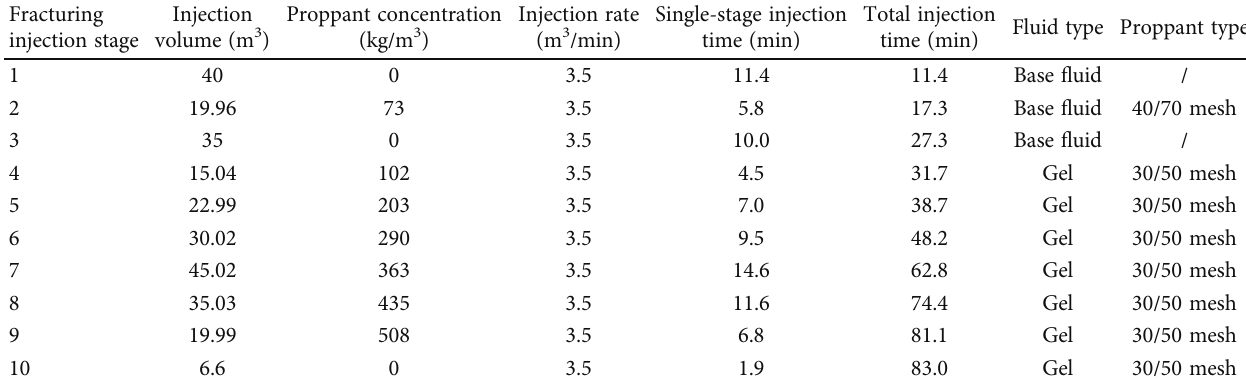
Table 3: The injection procedure for hydraulic fracturing